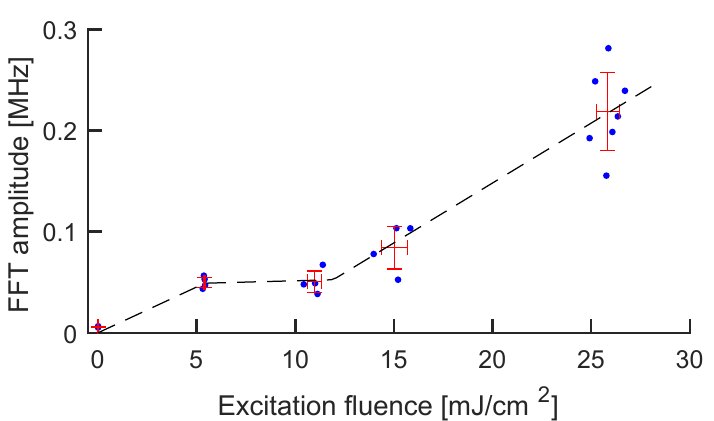
Figure 4. Amplitude of the main Fourier peak vs. pump laser fluence. The blue dots represent the experimental points, while the red crosses represent the average ± standard deviation for each group of measurements. The black curve is a guide to the eye showing the three lines associated with the three excitation regimes: regular PA generation, reshaping, and